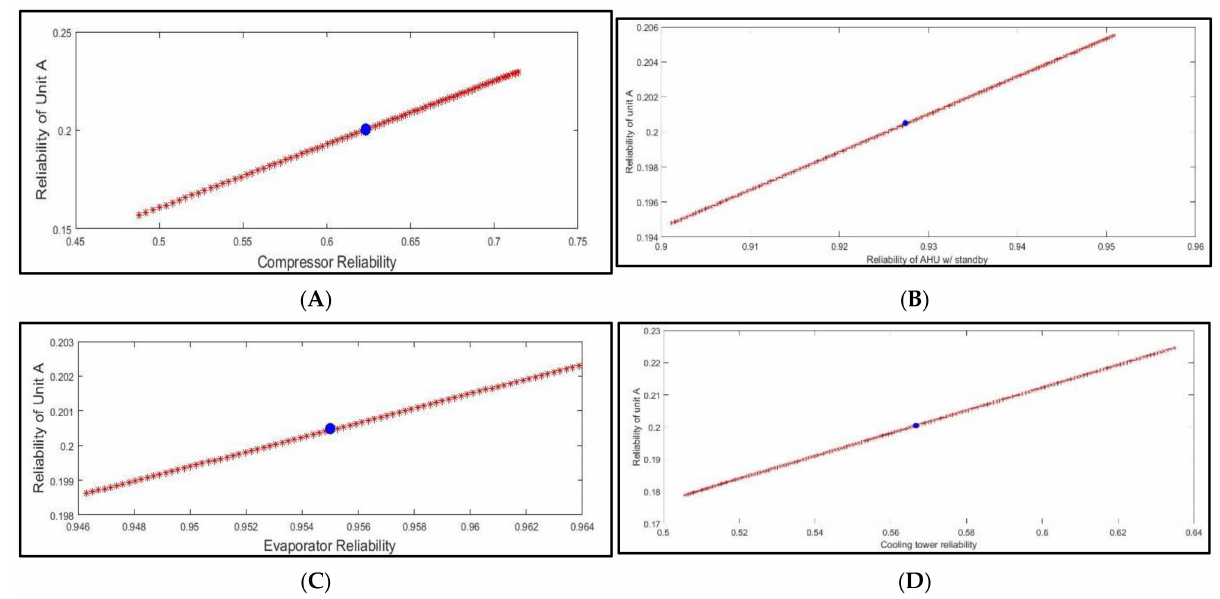
Figure 6. The sensitivity analysis of unit A’s reliability based on changes of failure parameters for the compressor ( A ), the AHU ( B ), the evaporator ( C ) and the cooling tower ( D